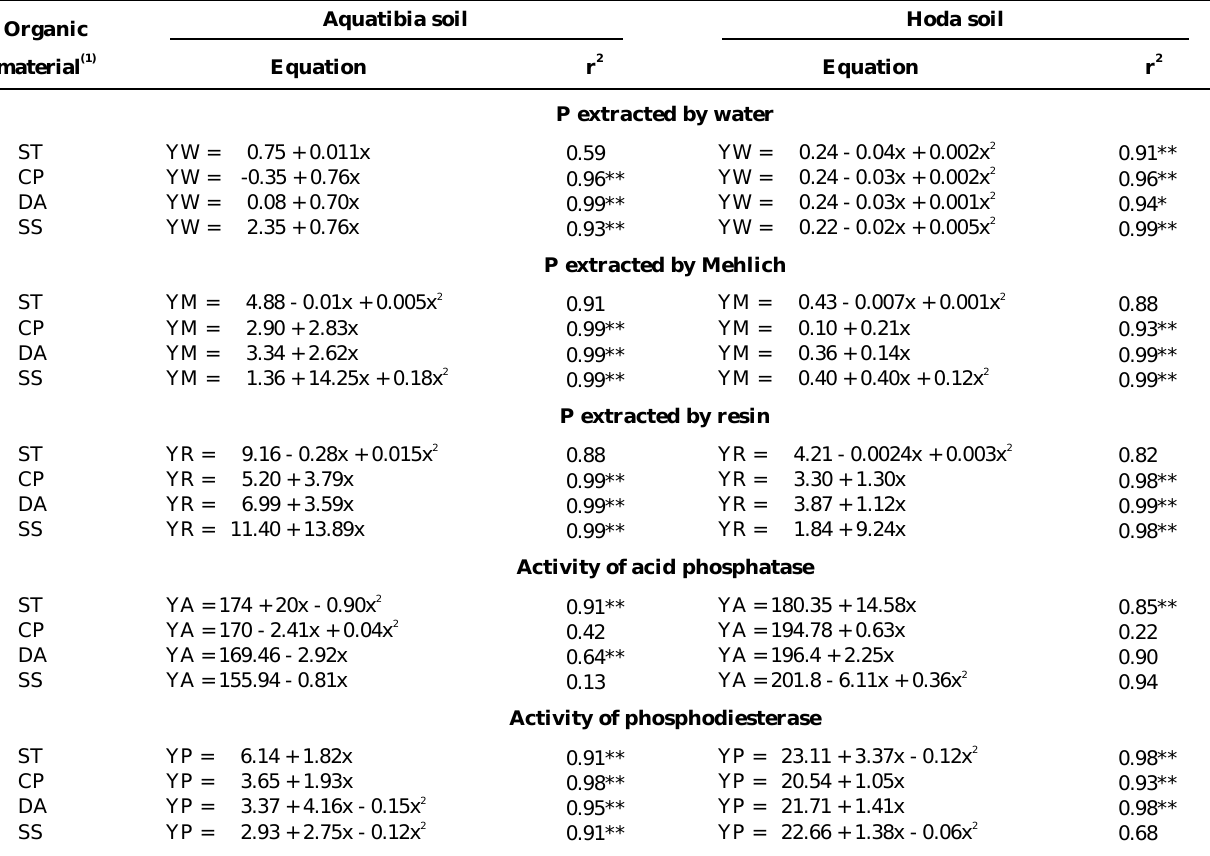
Table 4. Regression equations and determination coefficients obtained for P extracted by water